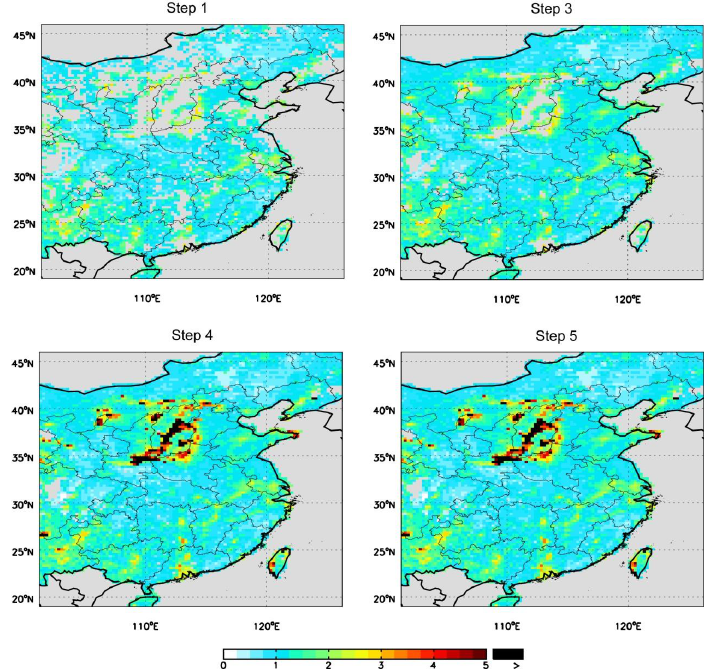
Fig. 7. Scaling factors for anthropogenic emissions ( k a ) determined at steps 1, 3, 4 and 5 of the inversion process described in Fig. 6 and Sect. 4.1.2. Step 2 does not affect k a and thus is not presented. Results at steps 4 and 5 are for January in particular. Areas outside the territory of China or with undetermined k a are shown in grey.